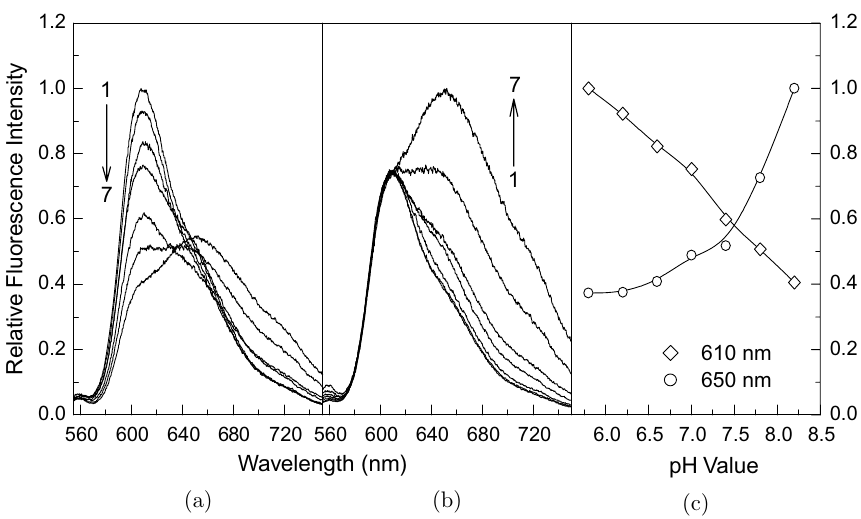
Fig. 10. (a) Fluorescence emission spectra of HB in HSA solution with various pH values from 5.8 to 8.2. (b) The normalized °uorescence spectra to the 610 nm peak. (c) pH-dependent °uorescent intensity at 610 and 650 nm. 73